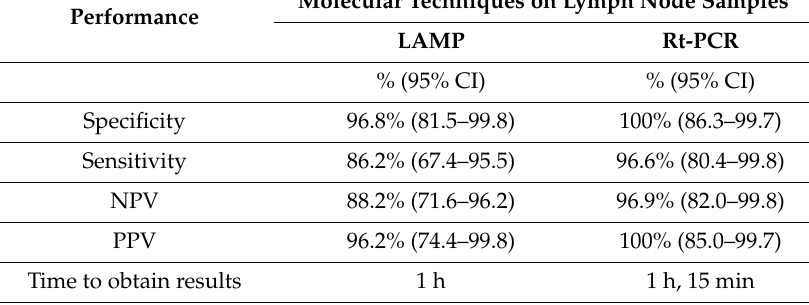
Table 2. Performances of molecular techniques (LAMP and Rt-PCR) tested on lymph node samples and 95% Confidence intervals (95%